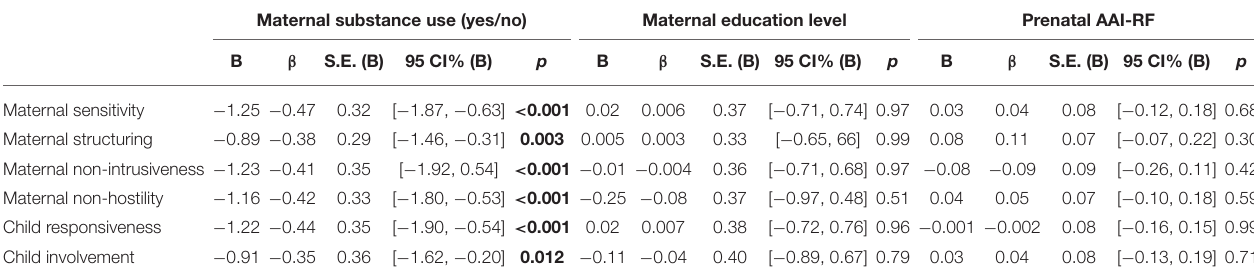
TABLE 4 | Associations between maternal prenatal AAI-RF and maternal and child EA at 4 months. Maternal substance use (yes/no) Maternal education level